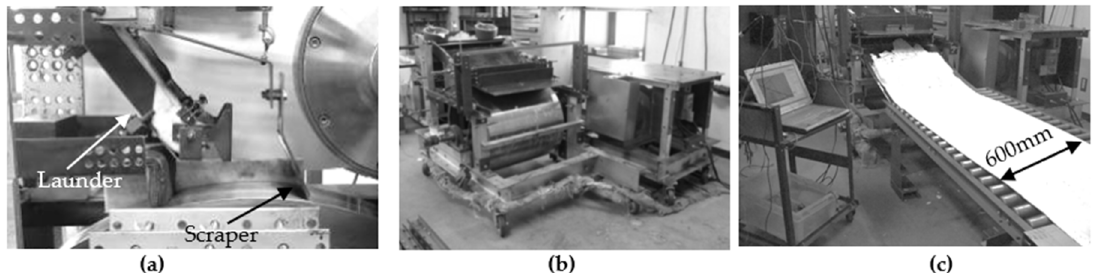
Figure 21. Photographs of SRCs. ( a ) Close-up of the area near the scraper equipped to the UDTRC, ( b ) A SRCs equipped with a 600 mm width roll, ( c ) the SRCs immediately after casting a 600 mm width strip and an as-cast 600 mm width strip.